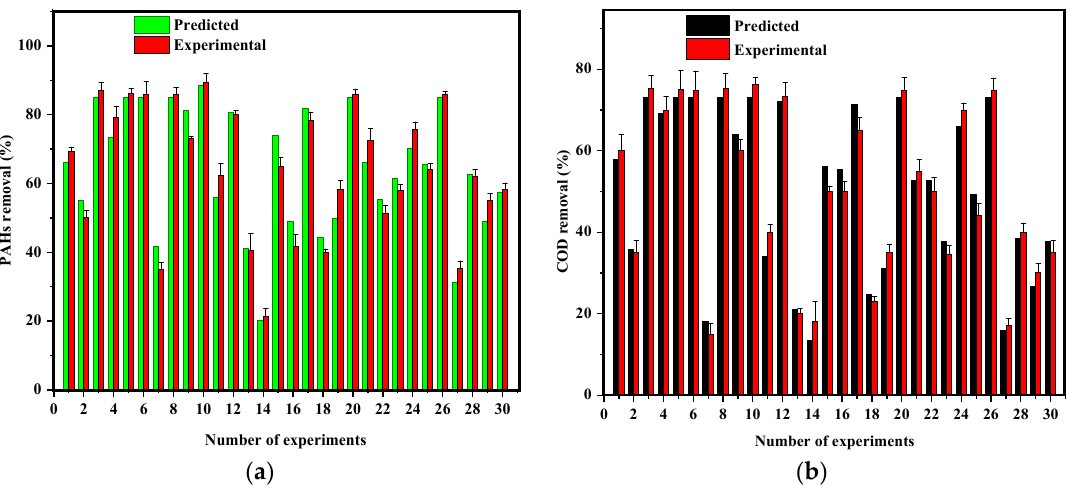
Figure 3. PAHs and COD removal against each set of experimental runs. ( a ) Predicted and experimental PAHs removal vs. experimental run, ( b ) predicted and experimental COD removal vs. experimental run.